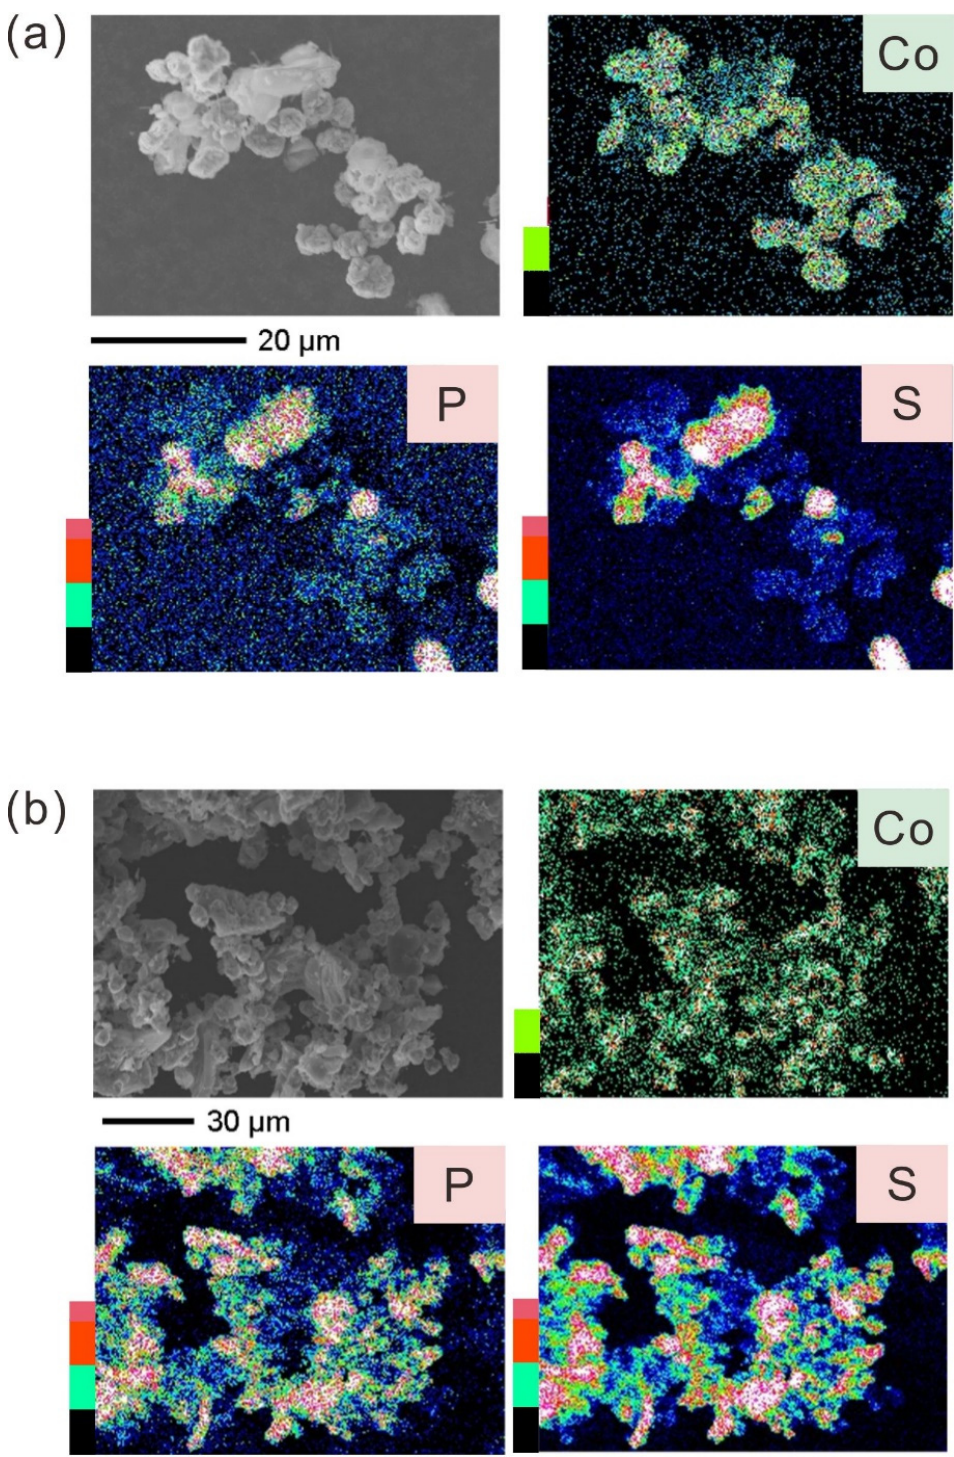
Figure 3. SEM–EDS analysis of composite electrodes prepared via ( a ) simple mixture and ( b ) solution processes using 80Li 2 S ∙ 20P 2 S 5 solid electrolytes. Elemental mappings for Co, P, and S are included. The color bar at the left-hand side corresponds to the intensity of the signal during the scanning acquisition.